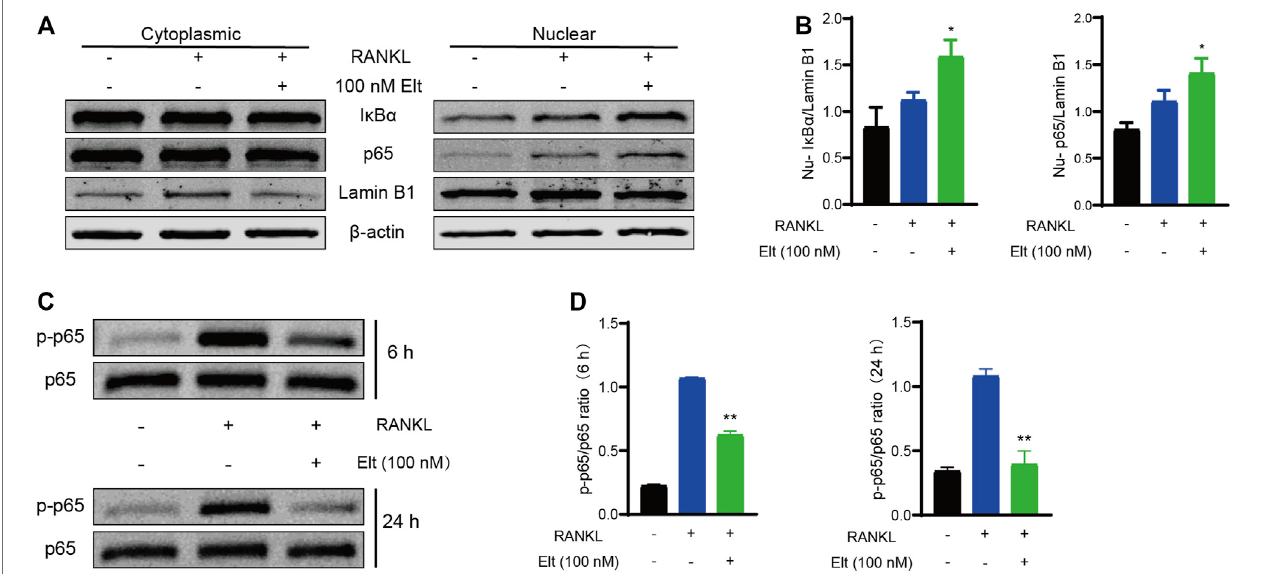
FIGURE 6 | Elt promotes nuclear accumulation of I κ B α – NF- κ B p65 and withholds the NF- κ B signaling pathway. (A) Cellular fractionation of BMMs cells shows similar increased nuclear levels of I κ B α and NF- κ B p65 upon Elt treatment in the presence of RANKL. Lamin B1 was used as nuclear protein marker; β - actin asacytosolicproteinmarker. (B) QuantitativeanalysisofnuclearexpressionofI κ B α and p65in Elttreatmentgroup. (C) Phosphorylation levelsofp65were detected within a short period of time after 6 h or 24 h of Elt treatment. (D) Quanti fi cation of the ratio of phosphorylated p65 to the corresponding total protein band. The above data are expressed as the mean ± SD; n = 3; Signi fi cant differences between the treatment and control groups are indicated as *p < 0.05.